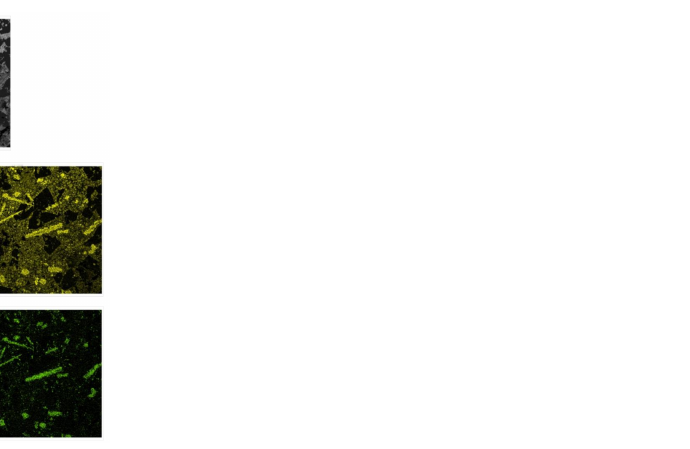
Figure 10. Elemental distributions of Zn–Al–Si–Fe alloy slag. ( a ) SEM of Zn–Al–Si–Fe alloy; ( b ) Dis- tribution of zinc; ( c ) Distribution of aluminum; ( d ) Distribution of silicon; ( e ) Distribution of iron.